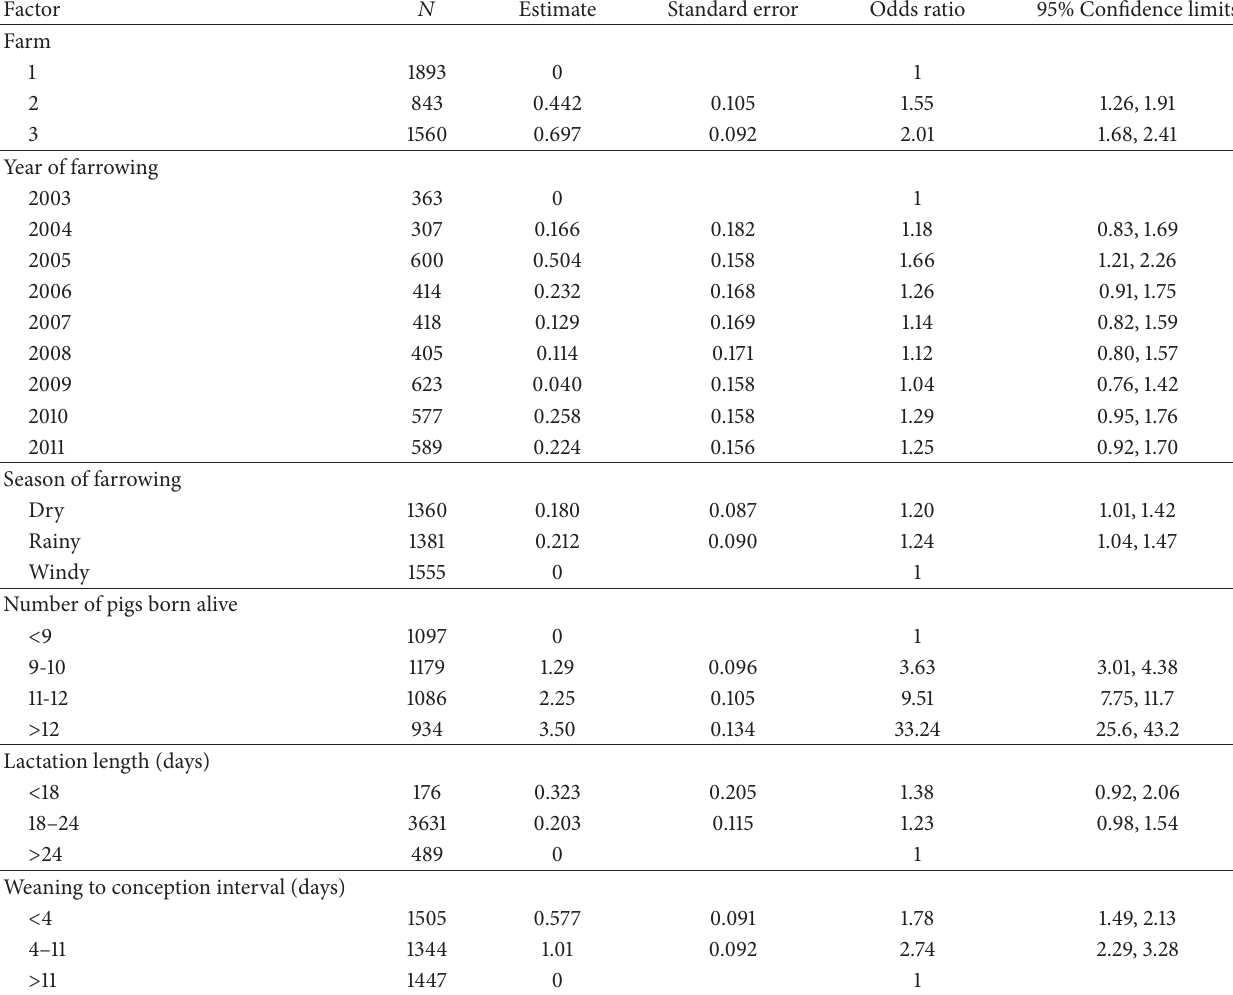
Table 1: Factors associated with the second-litter syndrome in three pig farms in Yucatan, Mexico, using a binomial logistic